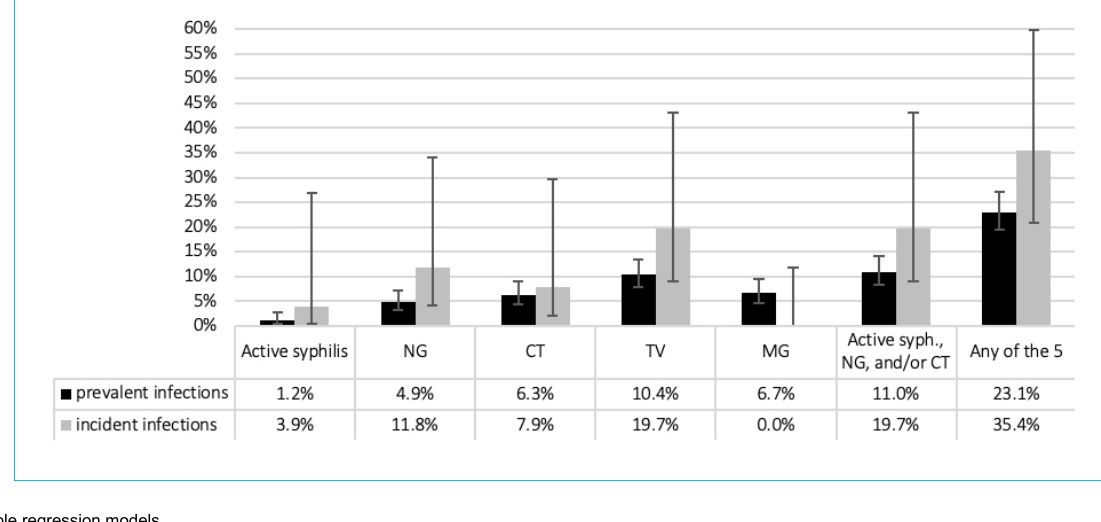
Table 3: Uni- and multivariable regression